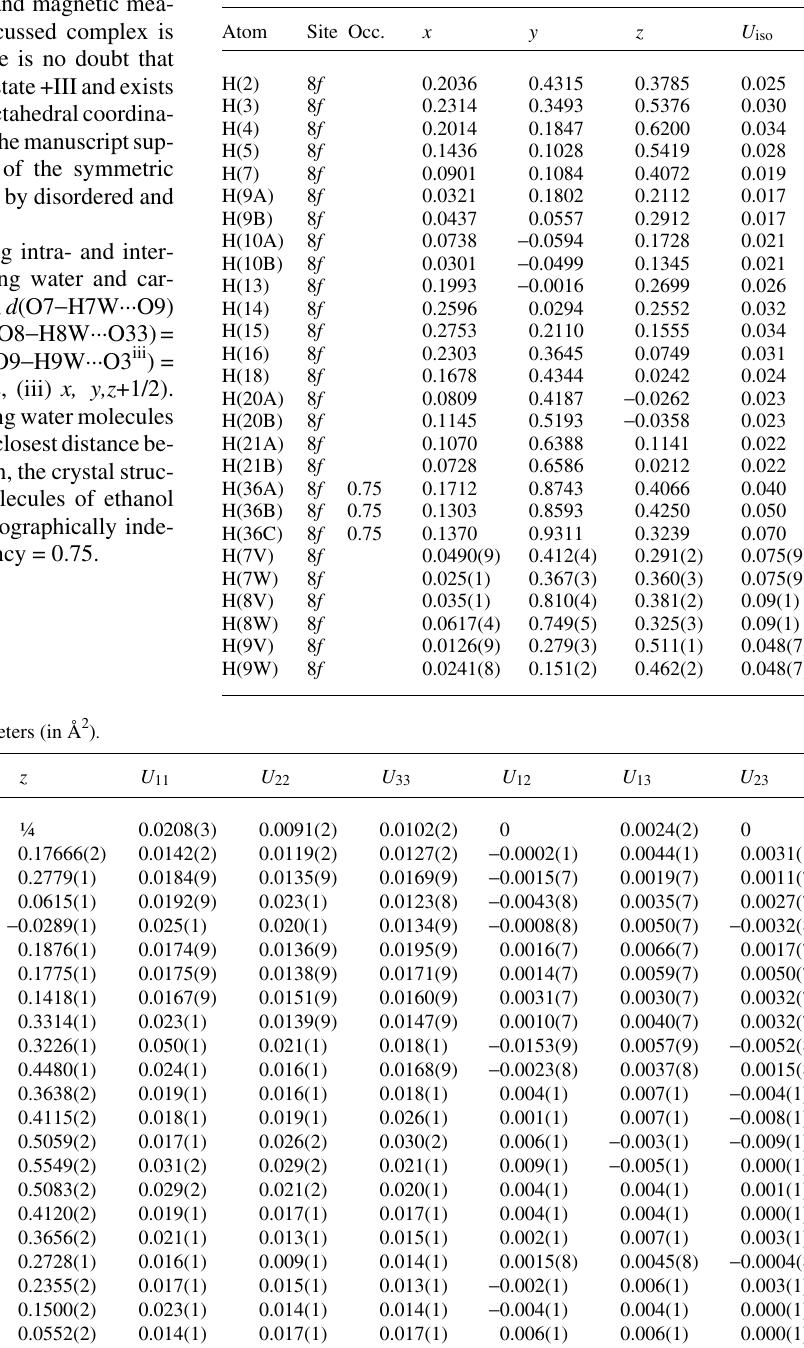
Table 2. Atomic coordinates and displacement parameters (in Å 2 )